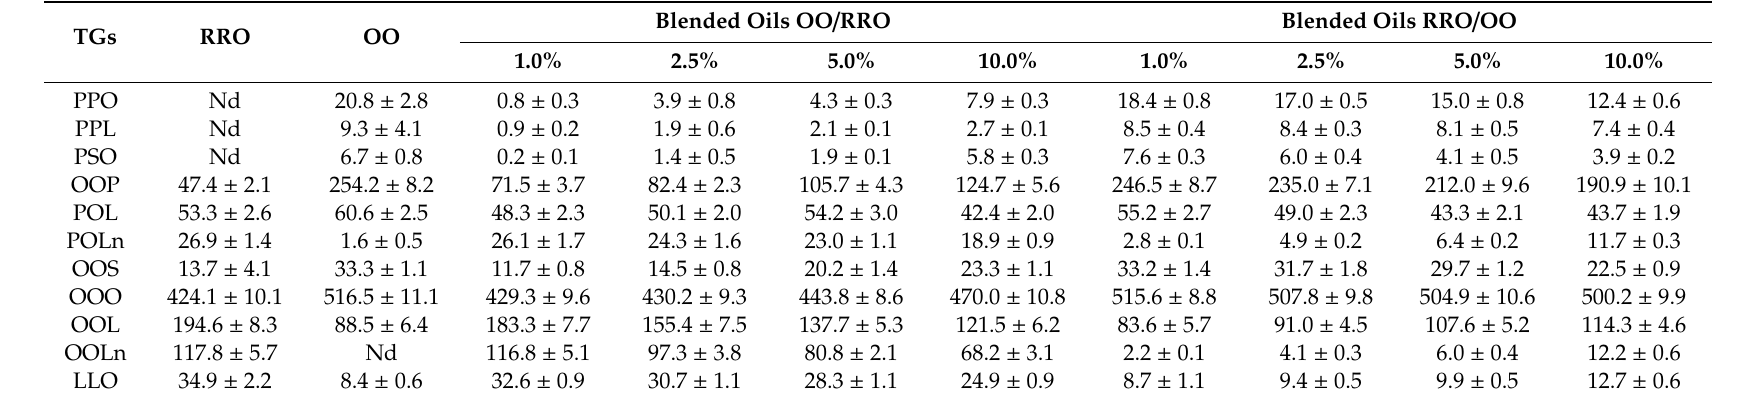
Table 2. Triacylglycerol levels in refined rapeseed oil, olive oil, and their blends (mg /